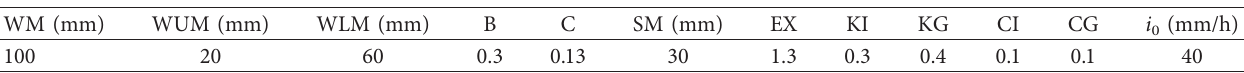
Table 4: Parameters of Xin’anjiang